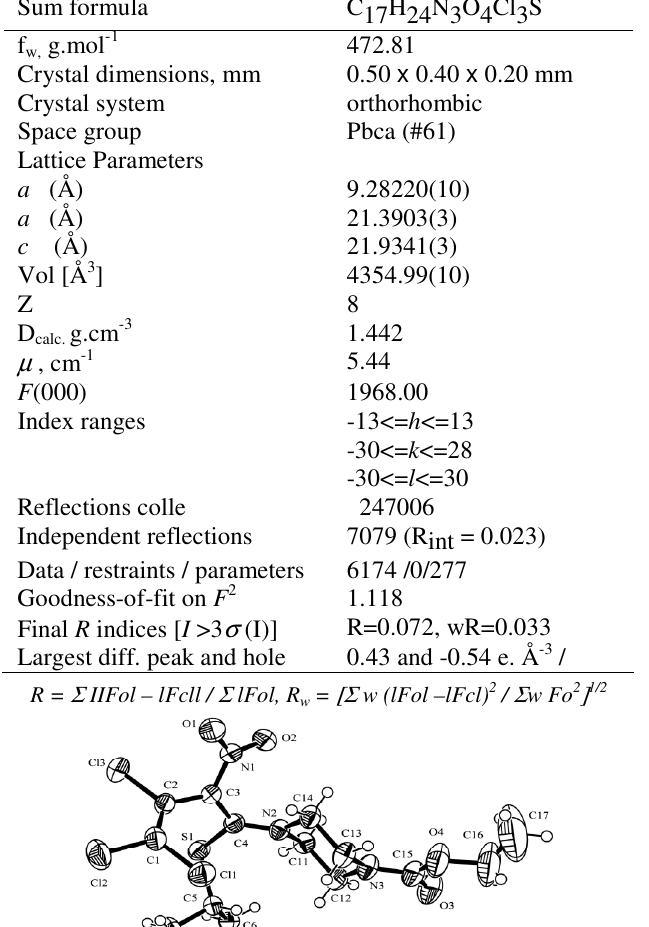
Table 1. Crystallographic data and structure refinement for compound 4g